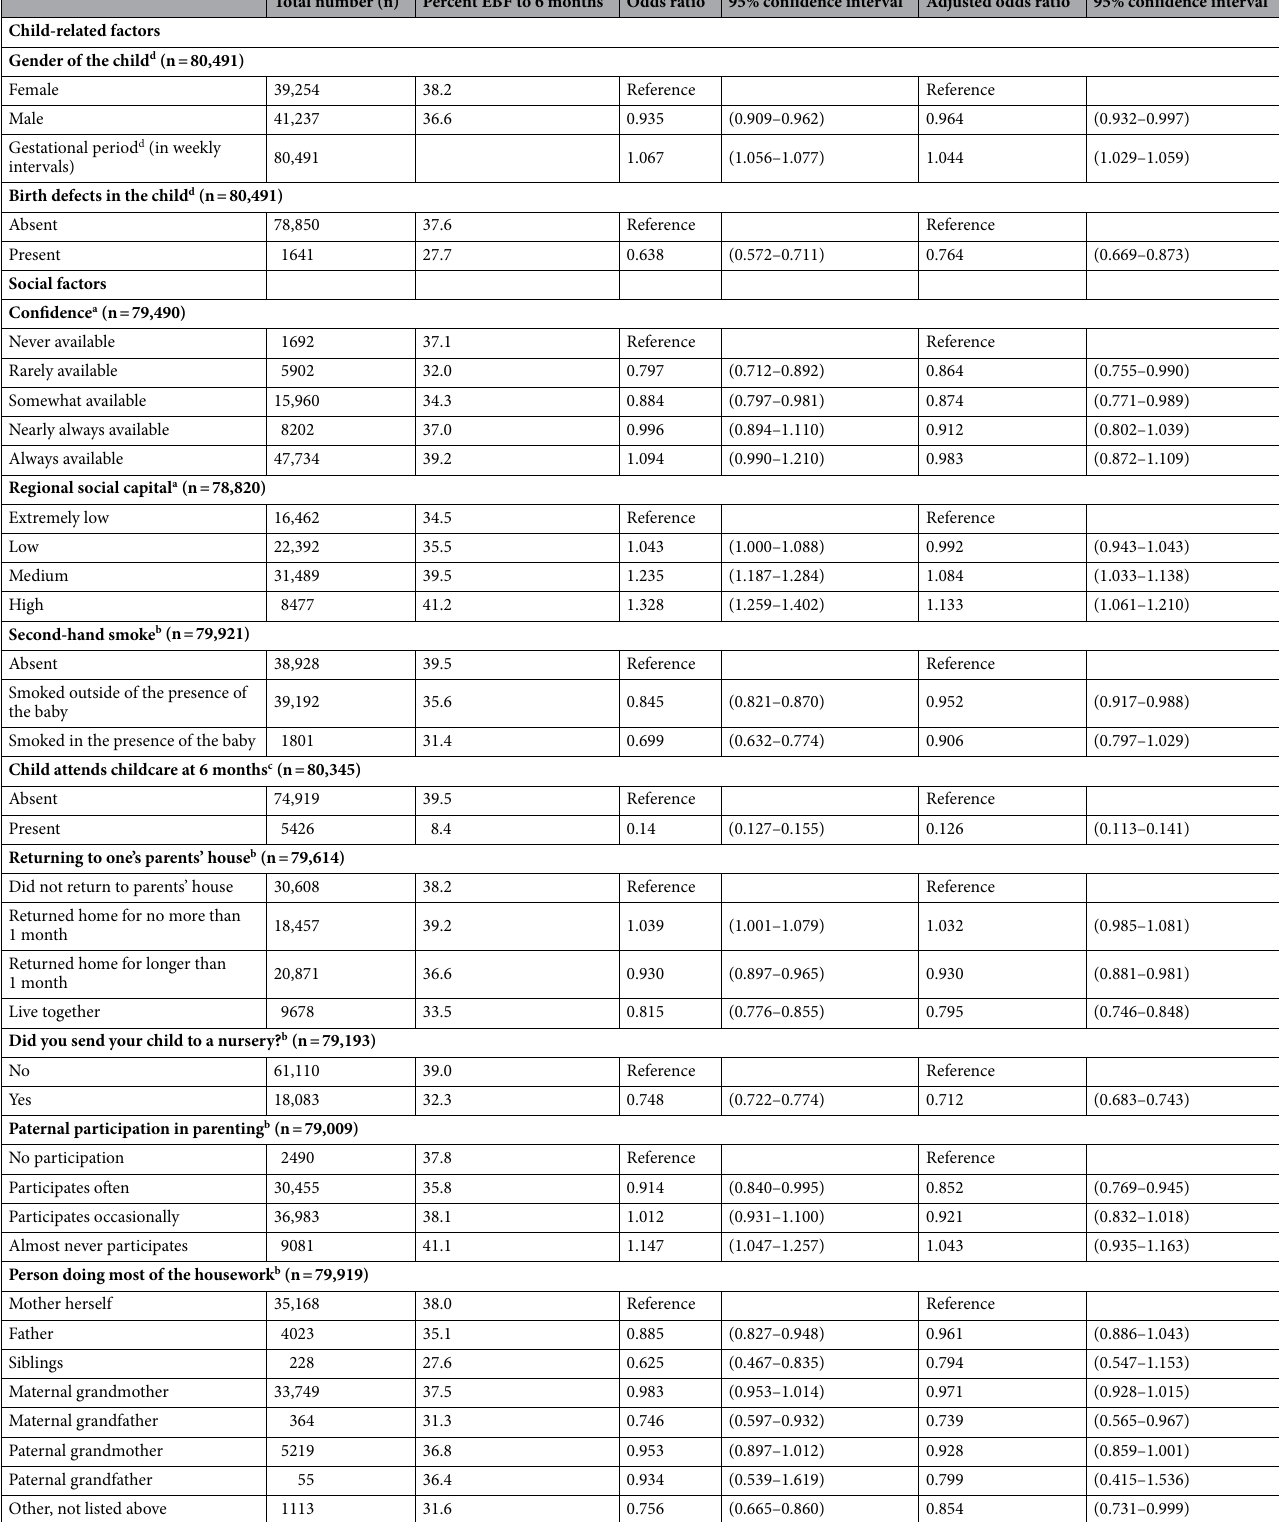
Table 2. Environmental factors influencing EBF rates until 6 months postpartum in Japan. Data acquisition. a During mid-pregnancy/ b 1 month postpartum/ c 6 months postpartum/ d attending physician diagnosed just after